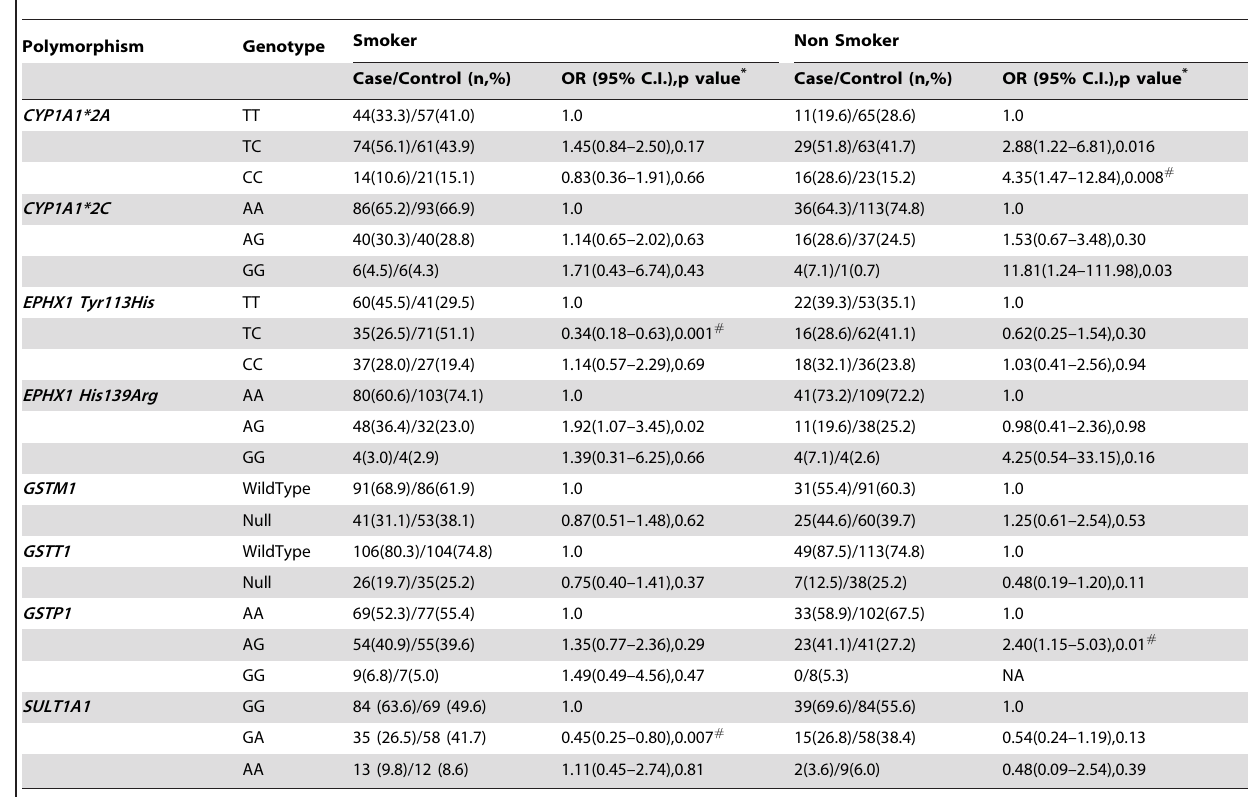
Table 3. Main effects of genotypes on lung cancer risk stratified by smoking.